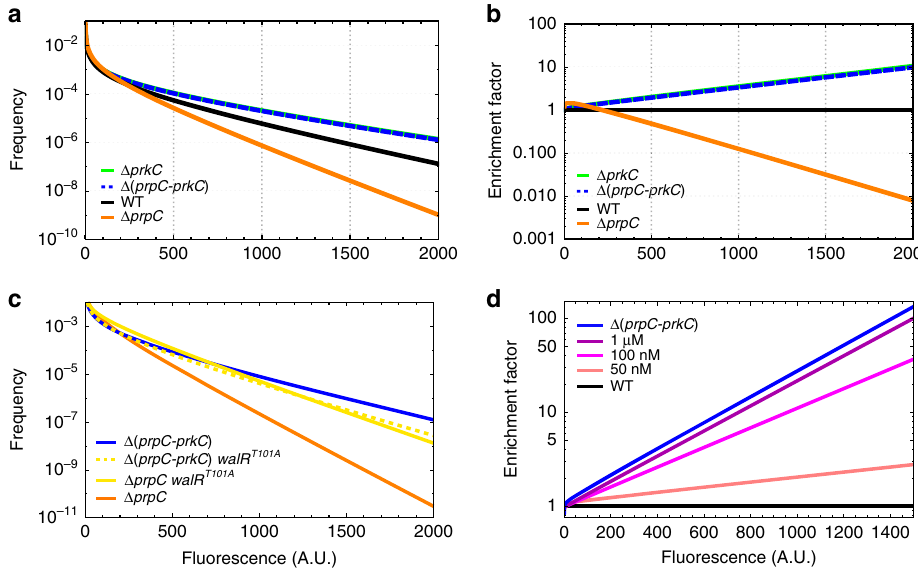
Fig. 3 Multisite phosphorylation causes exponential changes in the abundance of cells with a given level of sasA expression. a Functional fi ts of auto fl uorescence-free distributions of sasA expression. A deconvolution algorithm was used to remove the contribution of auto fl uorescence from the measured distributions of sasA expression shown in Fig. 2b. Validation of the fi ts are shown in Supplementary Fig. 7. b Effect of PrkC on the distribution of sasA expression. For each genotype in a the frequency of cells with a given level of sasA expression was normalized against the equivalent frequency in the WT population. On this semi-logarithmic plot, straight lines indicate that the enrichment factor changes ~exponentially with fl uorescence. c PrkC- dependent regulation of cell-to-cell variability in sasA is WalR Thr-101-dependent. P sasA - yfp reporter activity was quanti fi ed by fl ow cytometry in a Δ prpC walR T101A (yellow, solid) background and compared to Δ prpC (orange), Δ ( prpC-prkC ) (blue), and Δ ( prpC-prkC ) walR T101A (yellow, dashed) backgrounds in the same experiment. Plots were generated by applying the deconvolution method described in a to the measured data in Supplementary Fig. 8A. d Gradual inhibition of PrkC results in progressive enrichment of cells with elevated levels of sasA . P sasA - yfp reporter activity was quanti fi ed by fl ow cytometry during treatment with increasing concentrations of staurosporine: 0 (solvent only; black), 50 nM, 100 nM, and 1 µ M (shades of magenta), in otherwise WT populations. For reference, a Δ ( prpC-prkC ) (blue) population treated with solvent only is shown; note that the effect of staurosporine saturates at this level. Plots were generated by applying the deconvolution method described in a to the measured data in Supplementary Fig. 8B, C. For each condition the frequency of cells with a given level of sasA expression was normalized against the equivalent frequency in the WT population. As in b , straight lines indicate that enrichment increases ~exponentially with fl uorescence. Enrichment becomes more pronounced as the concentration of staurosporine increases and saturates at the level of complete inhibition ~ Δ ( prpC-prkC